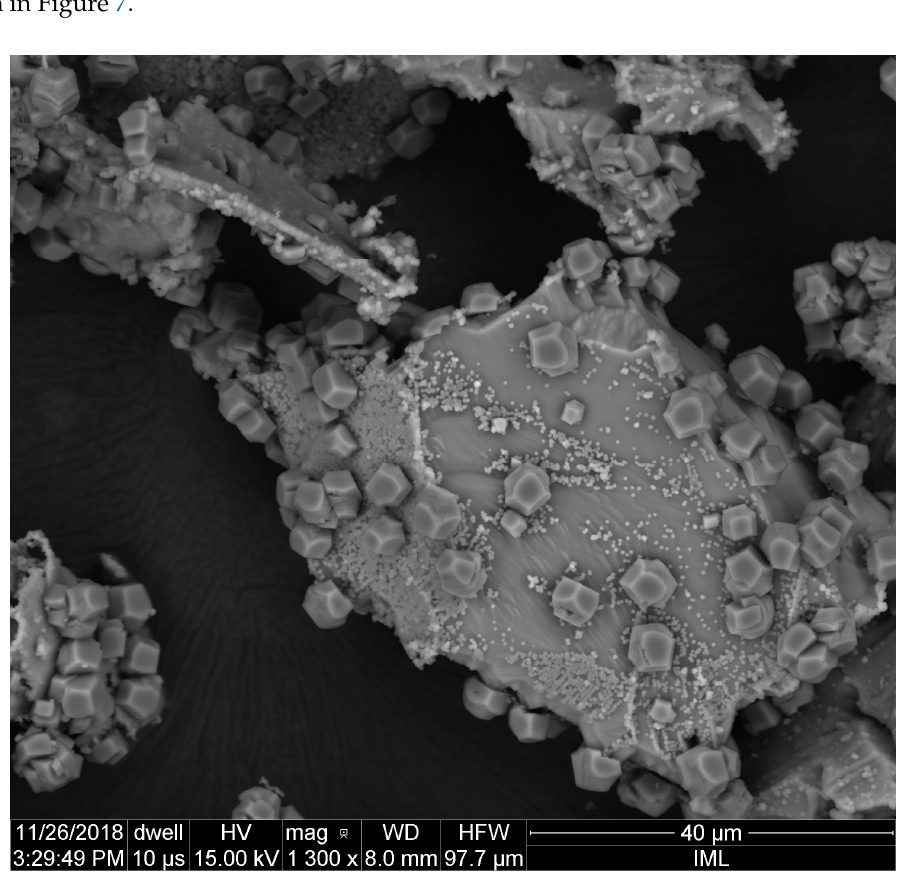
Figure 7. SEM analysis of initial olivine sample after carbonation.